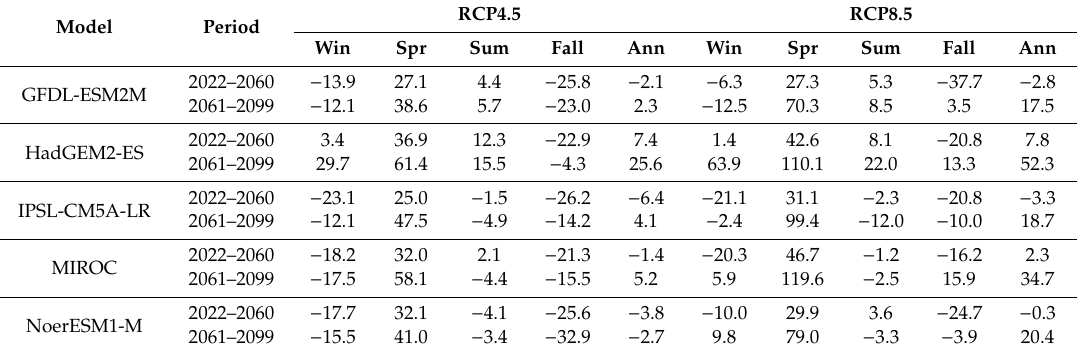
Table 5. Variations in the temporal projected average river flow at the annual and seasonal scales